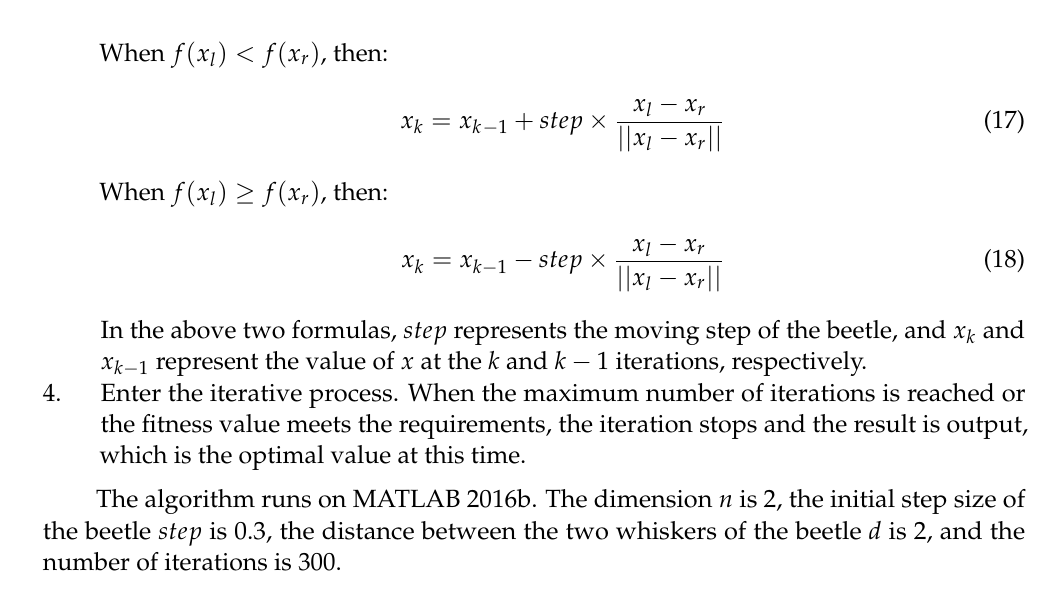
50 − 1000 Table 3. Turning empirical model parameters. Fc C